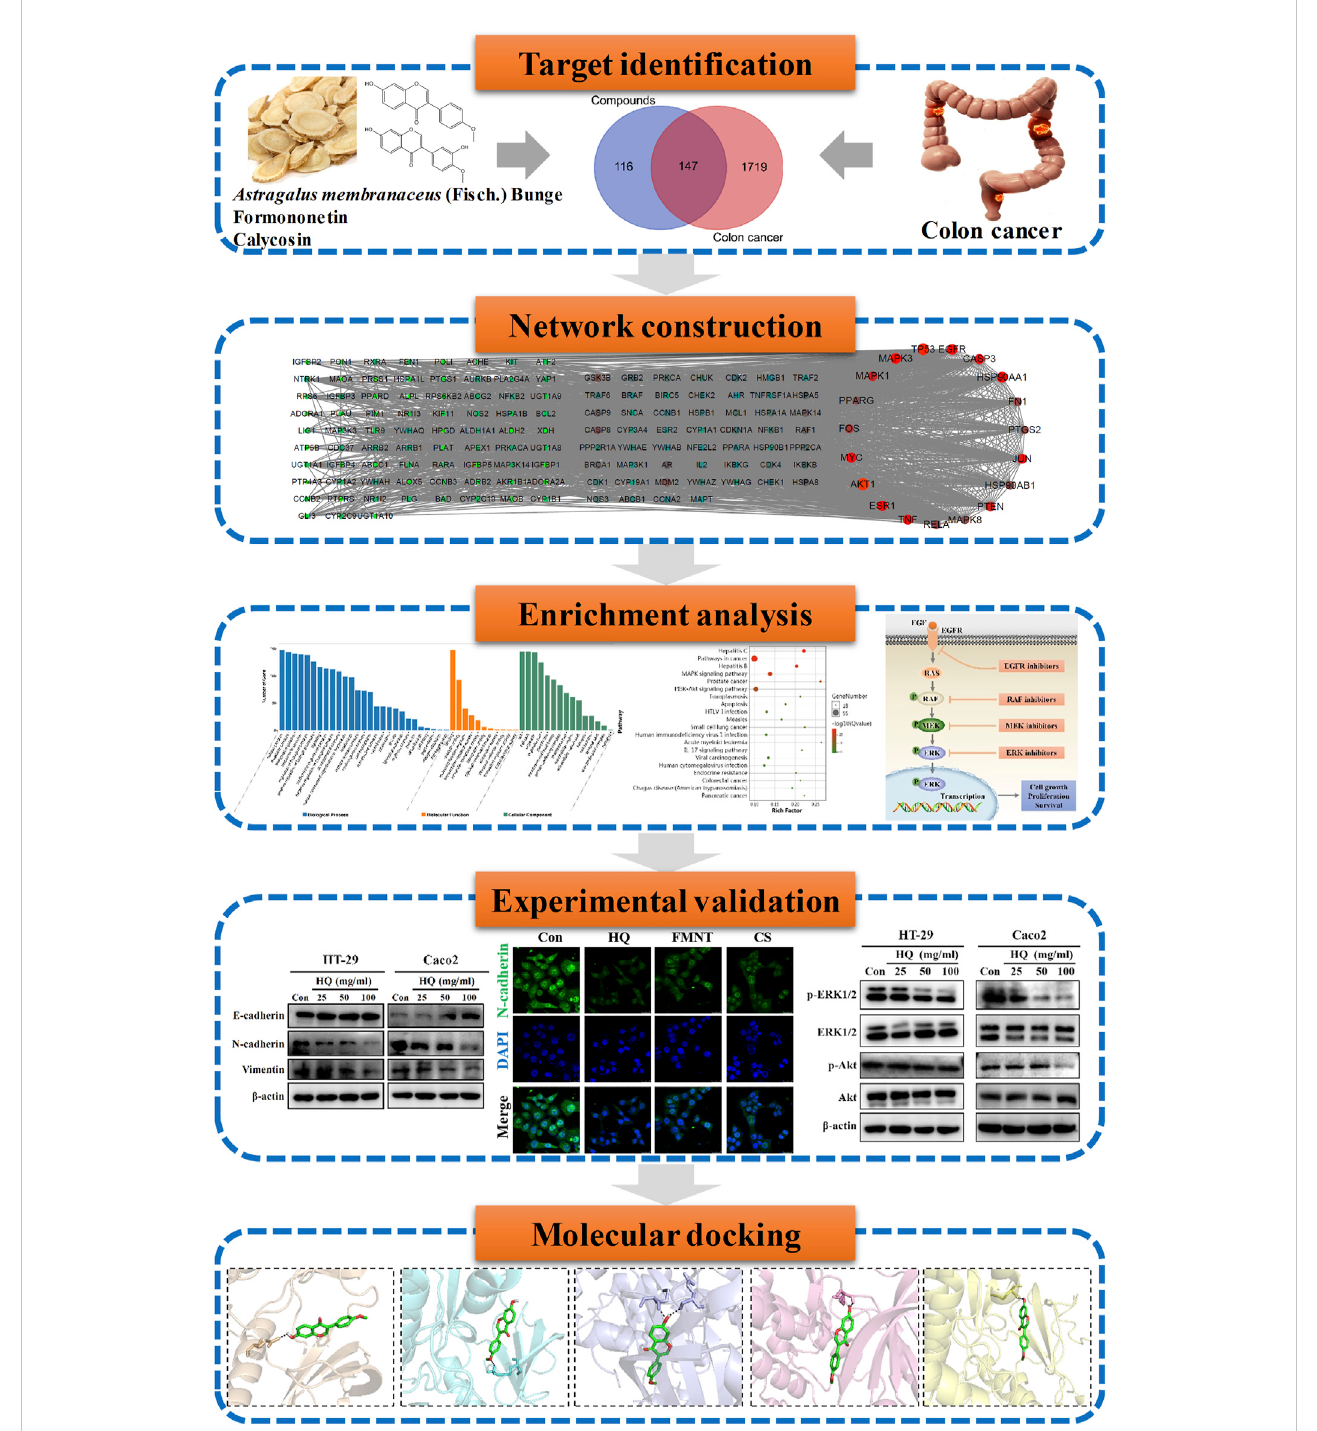
FIGURE 1 Technological road-map. The whole technical roadmap was divided into fi ve steps, including target identi fi cation, network construction, enrichment analysis, experimental validation and a molecular docking study.